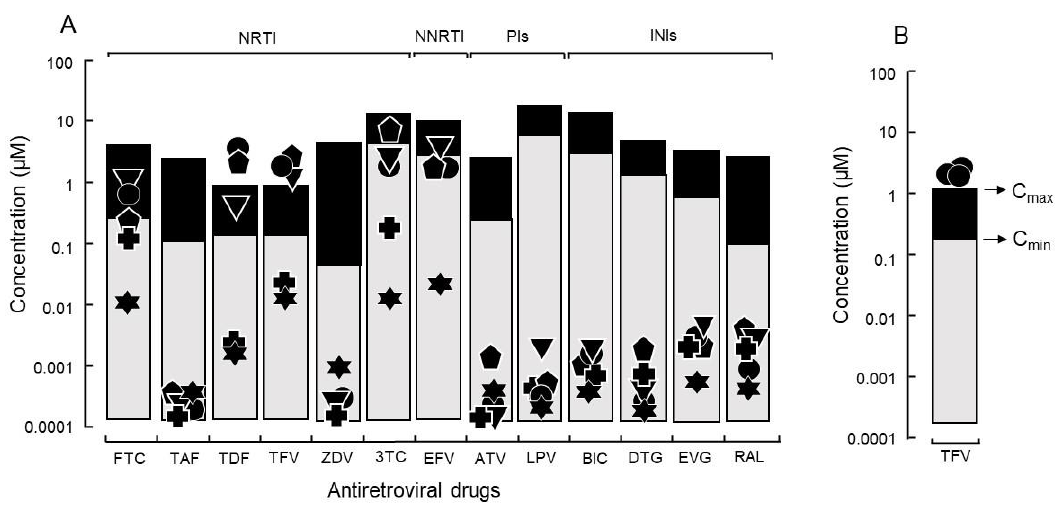
Figure 2. ( A ) The IC 90 of antiretroviral drugs against isolates without known drug-resistance muta- Figure 2. (A) The IC 90 of antiretroviral drugs against isolates without known drug-resistance muta- Figure 2. (A) The IC 90 of antiretroviral drugs against isolates without known drug-resistance muta- tions and relations with C min and C max . Thirteen synthetic antiretroviral compounds were evaluated: tions and relations with C min and C max . Thirteen synthetic antiretroviral compounds were evaluated: tions and relations with C min and C max . Thirteen synthetic antiretroviral compounds were evaluated: six nucleoside/nucleotide reverse transcriptase inhibitors (NRTIs) (FTC: emtricitabine, 3TC: lamivu- six nucleoside/nucleotide reverse transcriptase inhibitors (NRTIs) (FTC: emtricitabine, 3TC: lamiv- six nucleoside/nucleotide reverse transcriptase inhibitors (NRTIs) (FTC: emtricitabine, 3TC: lamiv- Figure 2. (A) The IC 90 of antiretroviral drugs against isolates without known drug-resistance muta- udine, TAF: tenofovir alafenamide, TFV: tenofovir, TDF: tenofovir disoproxil fumarate, and ZDV: dine, TAF: tenofovir alafenamide, TFV: tenofovir, TDF: tenofovir disoproxil fumarate, and ZDV: udine, TAF: tenofovir alafenamide, TFV: tenofovir, TDF: tenofovir disoproxil fumarate, and ZDV: tions and relations with C min and C max . Thirteen synthetic antiretroviral compounds were evaluated: zidovudine). One non-nucleoside reverse transcriptase inhibitor (NNRTI) (EFV: efavirenz); two pro- zidovudine). One non-nucleoside reverse transcriptase inhibitor (NNRTI) (EFV: efavirenz); two zidovudine). One non-nucleoside reverse transcriptase inhibitor (NNRTI) (EFV: efavirenz); two pro- six nucleoside/nucleotide reverse transcriptase inhibitors (NRTIs) (FTC: emtricitabine, 3TC: lamiv- tease inhibitors (PIs) (ATV: atazanavir and LPV: lopinavir); and four integrase inhibitors (INIs) (BIC: protease inhibitors (PIs) (ATV: atazanavir and LPV: lopinavir); and four integrase inhibitors (INIs) tease inhibitors (PIs) (ATV: atazanavir and LPV: lopinavir); and four integrase inhibitors (INIs) (BIC: udine, TAF: tenofovir alafenamide, TFV: tenofovir, TDF: tenofovir disoproxil fumarate, and ZDV: bictegravir, DTG: dolutegravir, EVG: elvitegravir, and RAL: raltegravir) against HIV with higher (BIC: bictegravir, DTG: dolutegravir, EVG: elvitegravir, and RAL: raltegravir) against HIV with bictegravir, DTG: dolutegravir, EVG: elvitegravir, and RAL: raltegravir) against HIV with higher zidovudine). One non-nucleoside reverse transcriptase inhibitor (NNRTI) (EFV: efavirenz); two pro- growth capability ( ● DR1509-397, ▼ DR1605-400, ⬟ S1506-064), lower growth capability (  growth capability ( ● DR1509-397, ▼ DR1605-400, ⬟ S1506-064), lower growth capability (  higher growth capability ( • DR1509-397, (cid:72) DR1605-400, S1506-064), lower growth capability tease inhibitors (PIs) (ATV: atazanavir and LPV: lopinavir); and four integrase inhibitors (INIs) (BIC: DR1606-559), and laboratory strain of HIV (  pNL4-3). Because of the presence of drug-resistance DR1606-559), and laboratory strain of HIV (  pNL4-3). Because of the presence of drug-resistance ( (cid:58) DR1606-559), and laboratory strain of HIV ( (cid:86) pNL4-3). Because of the presence of drug-resistance bictegravir, DTG: dolutegravir, EVG: elvitegravir, and RAL: raltegravir) against HIV with higher mutations, isolates of ⬟ S1506-064 and  DR1606-559 were not evaluated for ZDV and EFV, respec- growth capability ( ● DR1509-397, ▼ DR1605-400, ⬟ S1506-064), lower growth capability (  mutations, isolates of ⬟ S1506-064 and  DR1606-559 were not evaluated for ZDV and EFV, respec- mutations, isolates of S1506-064 and (cid:58) DR1606-559 were not evaluated for ZDV and EFV, respec- tively. ( B ) Tenofovir response to isolate ( ● DR1509-397) with the highest growth capability, was DR1606-559), and laboratory strain of HIV (  pNL4-3). Because of the presence of drug-resistance tively. ( B ) Tenofovir response to isolate ( ● DR1509-397) with the highest growth capability, was tively. ( B ) Tenofovir response to isolate ( • DR1509-397) with the highest growth capability, was evaluated using three different blood sources. mutations, isolates of ⬟ S1506-064 and  DR1606-559 were not evaluated for ZDV and EFV, respec- evaluated using three different blood sources. evaluated using three different blood tively. ( B ) Tenofovir response to isolate ( ● DR1509-397) with the highest growth capability, was evaluated using three different blood sources.